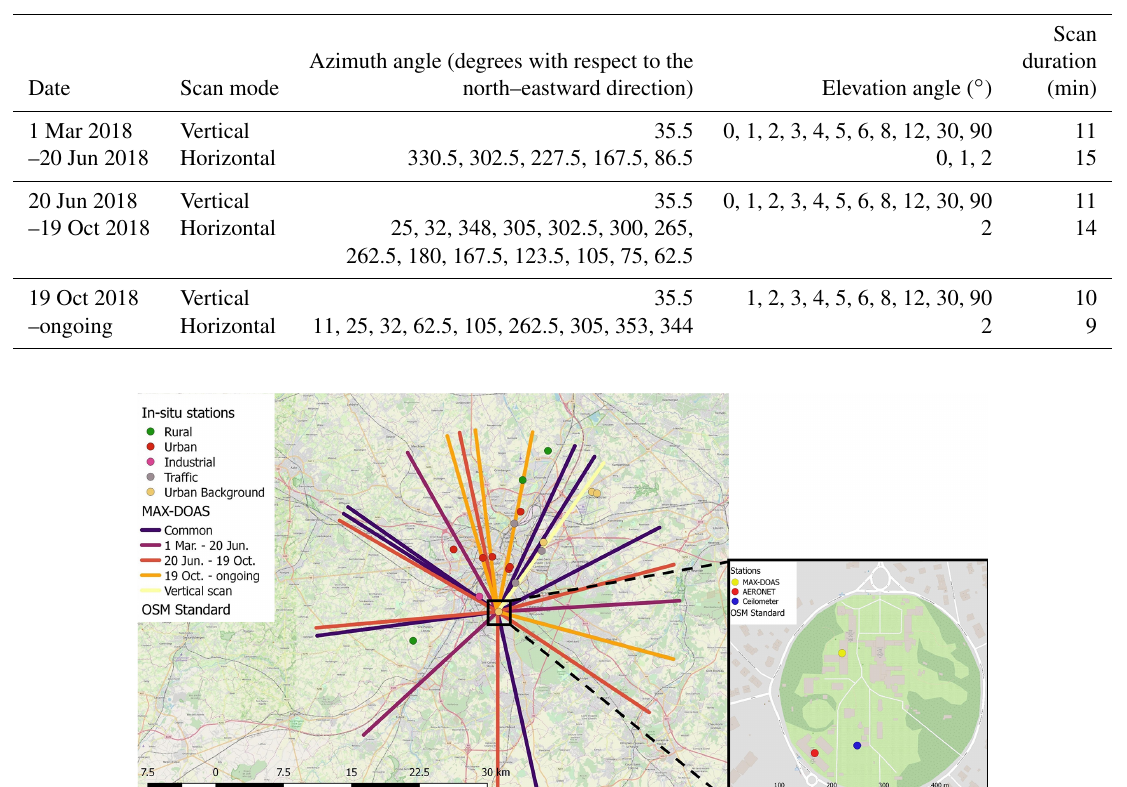
Table 1. MAX-DOAS experimental setup.